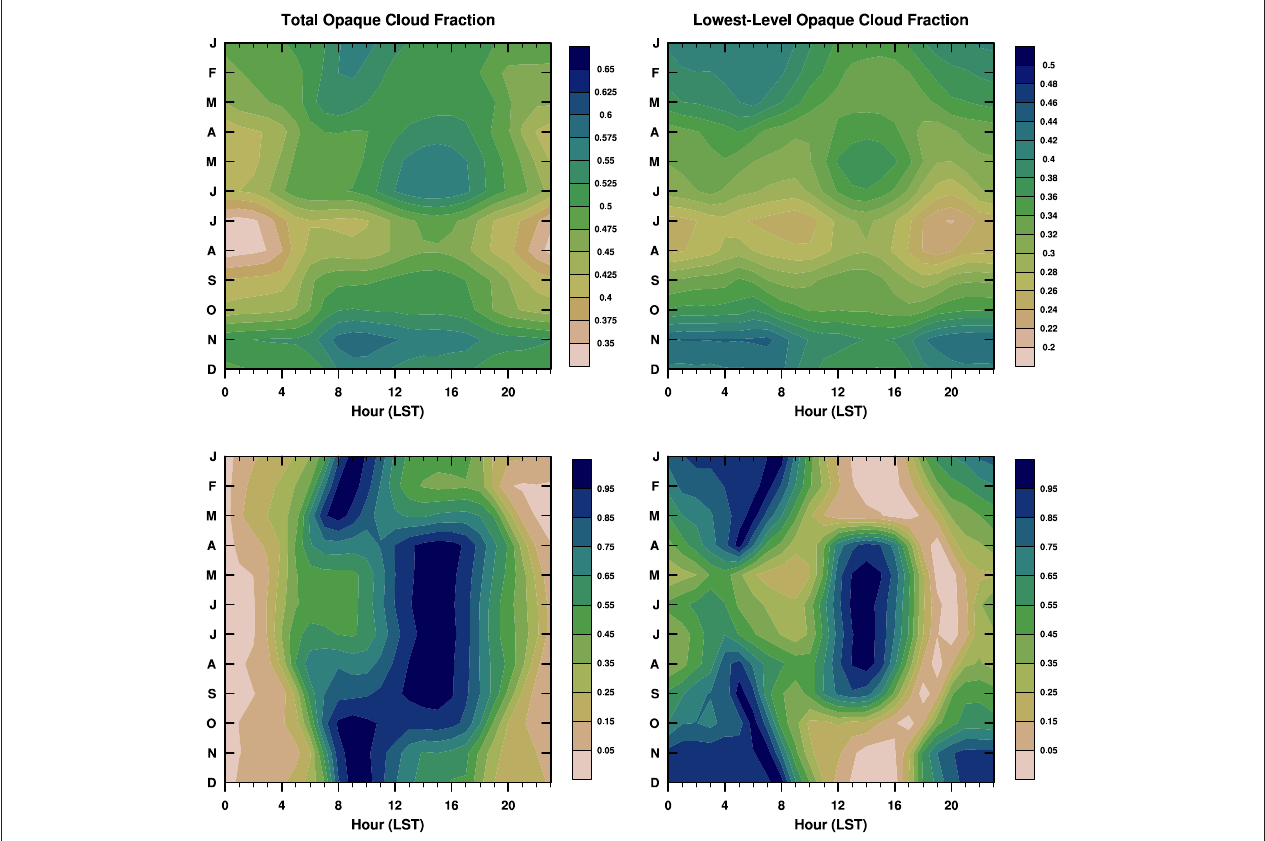
FIGURE 6 | The average diurnal cycle of total opaque cloud fraction and lowest-level opaque cloud fraction over the annual cycle (top), and (below) the normalized diurnal cycles of total opaque cloud cover fraction and lowest-level opaque cloud fraction, scaled so that 1 is the diurnal maximum and 0 is the